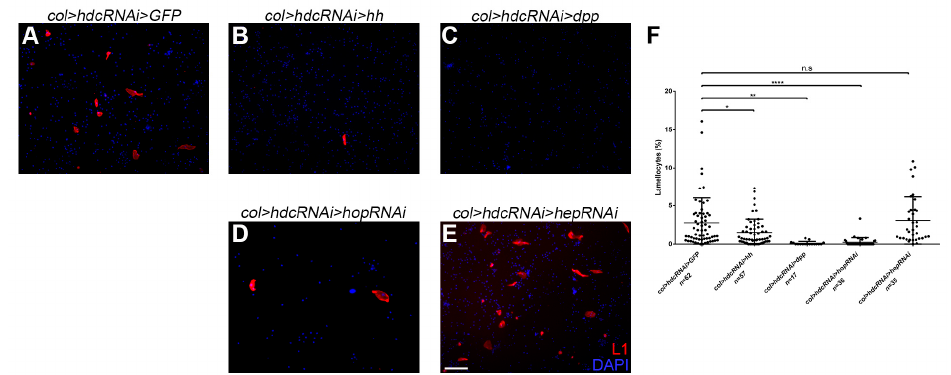
Figure 7. The interaction of Hdc with the signal transduction pathways of the lymph gland. ( A ) Silencing of hdc with the Pcol85-Gal4 driver in the PSC of the lymph gland resulted in differentiation of lamellocytes in naive larvae ( Pcol85-Gal4, UAS-hdcRNAi/+; UAS-2xEGFP/+ ); ( B – E ) Overexpression of hh ( B ) and dpp ( C ) with the col-Gal4 driver significantly reduced the proportion of lamellocytes (red) in the circulation of hdc -silenced larvae ( Pcol85-Gal4, UAS-hdcRNAi/UAS-hh(M4) , Pcol85-Gal4, UAS-hdcRNAi/UAS-dpp , respectively). Silencing of hop with RNA interference ( Pcol85-Gal4, UAS- hdcRNAi/UAS-hopRNAi ) (D) also resulted in the rescue of the hdc phenotype, while silencing of hep ( Pcol85-Gal4, UAS-hdcRNAi/UAS-hepRNAi ) (E) did not affect the phenotype significantly. Nuclei were stained with DAPI (blue). Hemocytes were visualized on a Zeiss Axioskope 2MOT epifluorescent microscope, original magnification x10 and processed with ImageJ and Adobe Photoshop CS2